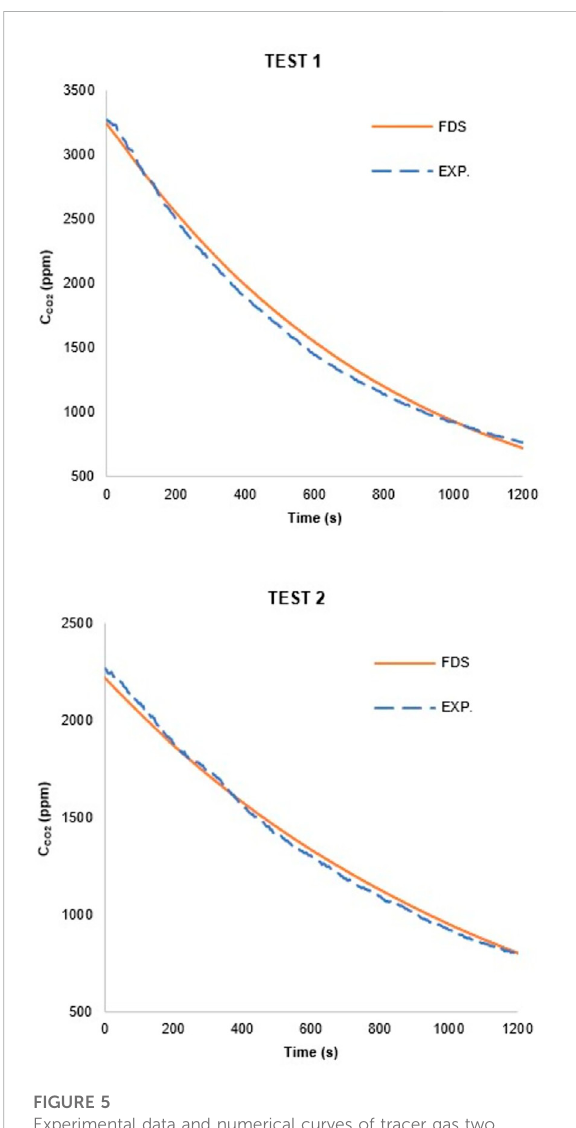
FIGURE 5 Experimental data and numerical curves of tracer gas two tests in the climatic